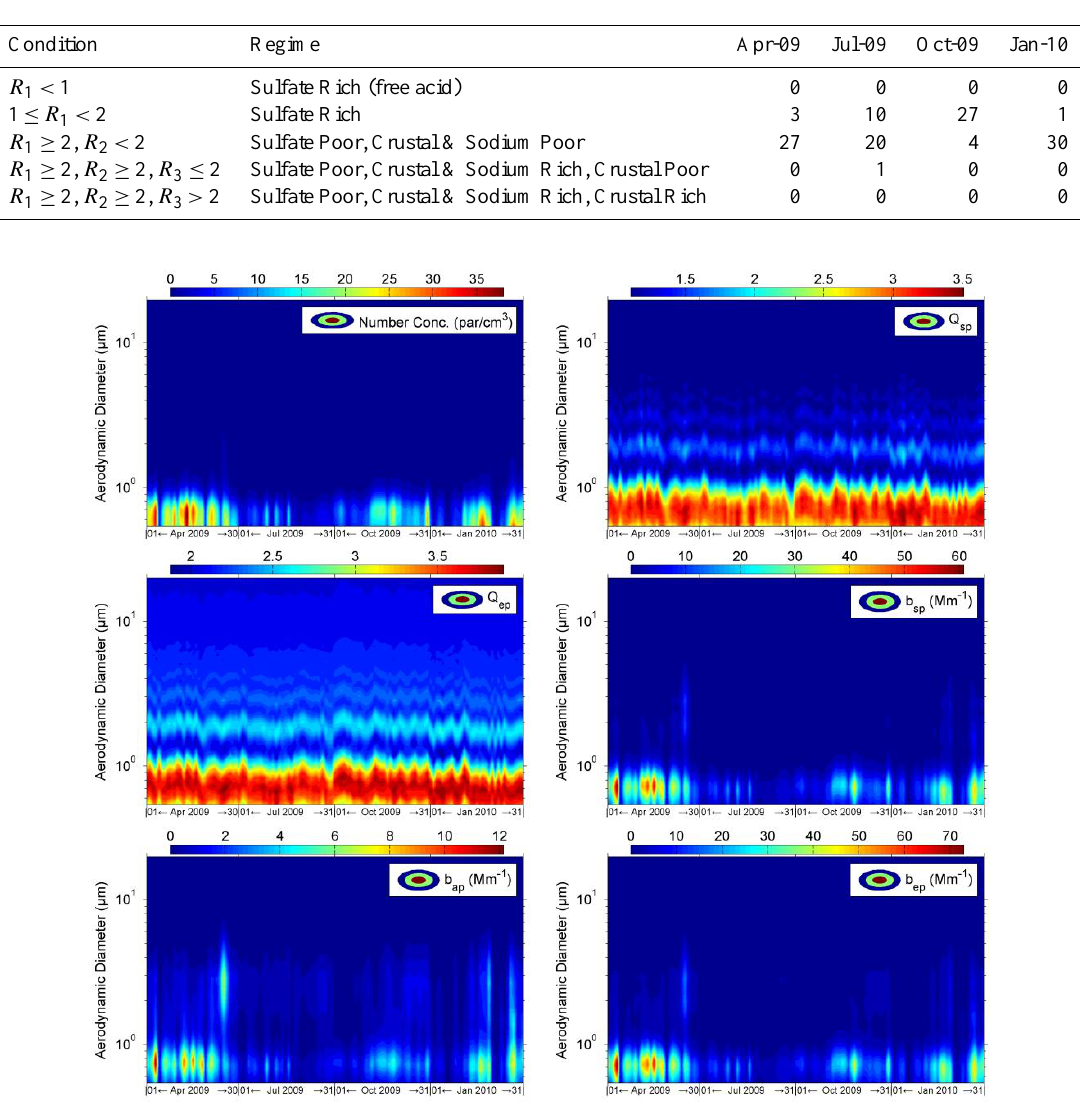
Figure 4 Temporal variations of aerosol particles number and the Mie 406 Fig. 4. Temporal variations of particles number and optical